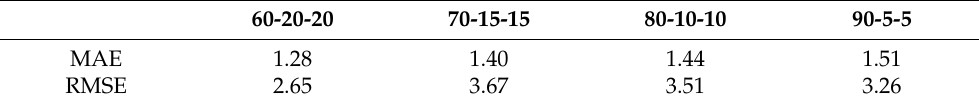
Figure 9. Histogram for all_values dataset, mean and standard deviation. Table 1. Dataset split percentage.